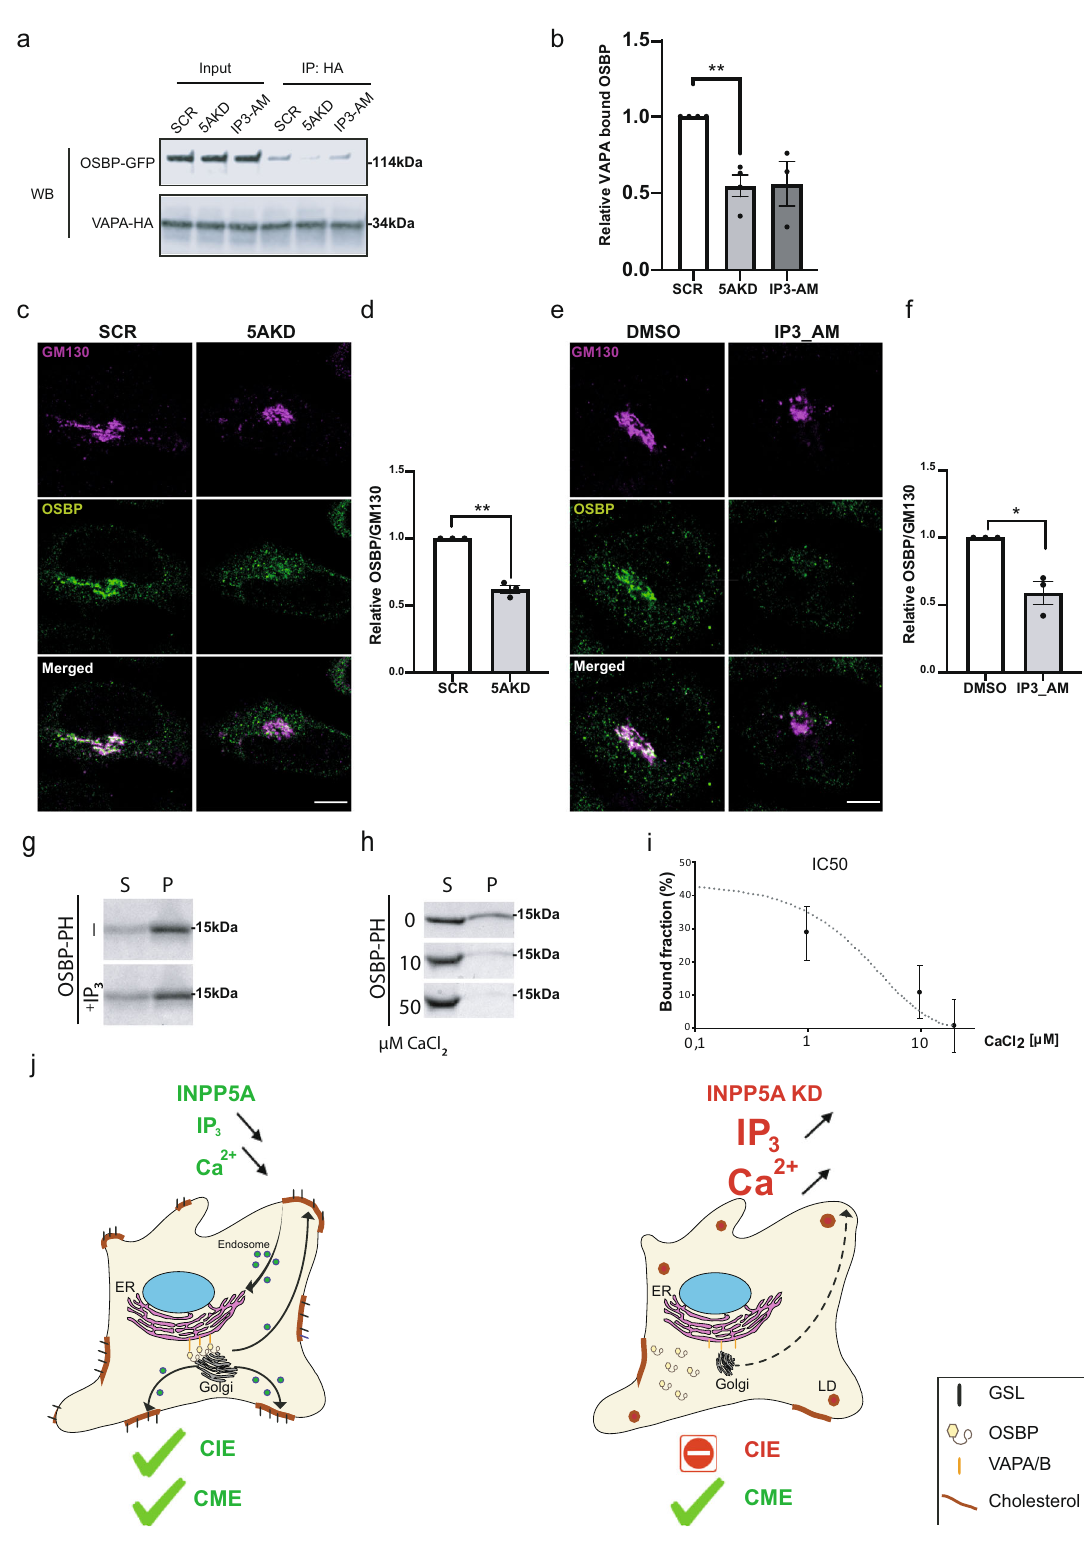
lipid content including complex glycosphingolipids (i.e., receptor lipids for bacterial toxins such as Shiga toxin). Instead, Gb3 loss from the surface of INPP5A-depleted cells is shown to be an indirect consequence of defects in cholesterol export from the ER to the Golgi complex, which instead is rerouted to lysosomes and lipid droplets (Figs. 3 and 4), compartments that either emanate from the ER (i.e., lipid droplets) or are in contact with it via MCS